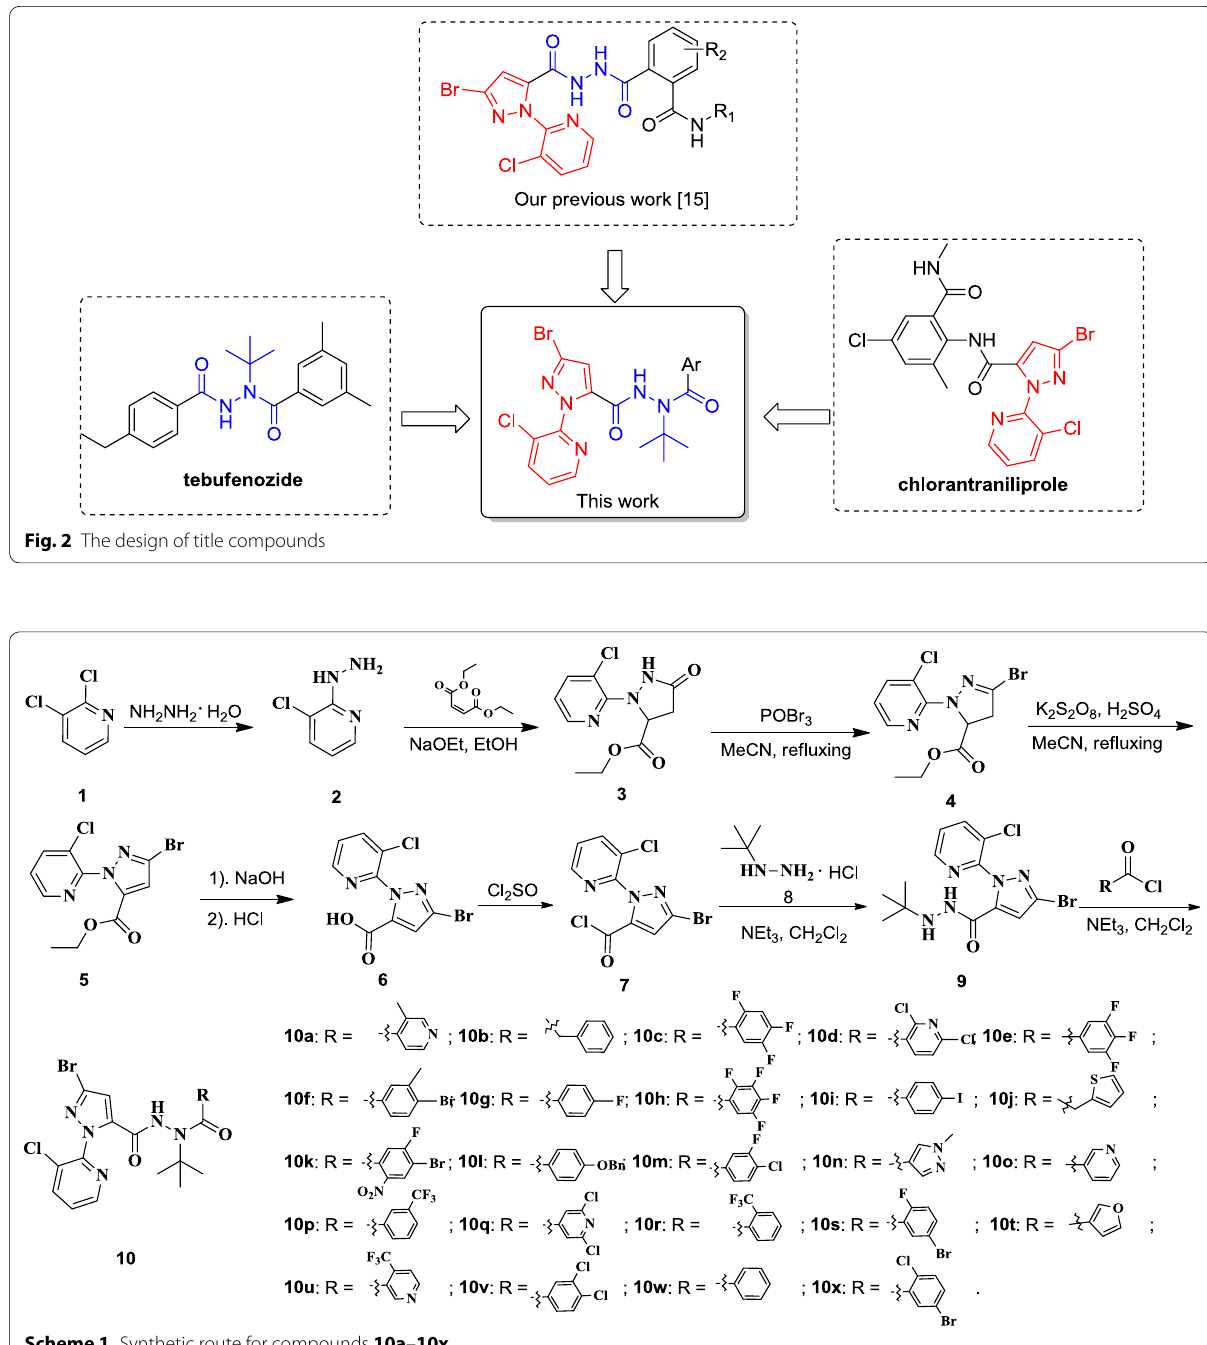
Scheme 1 Synthetic route for compounds 10a –